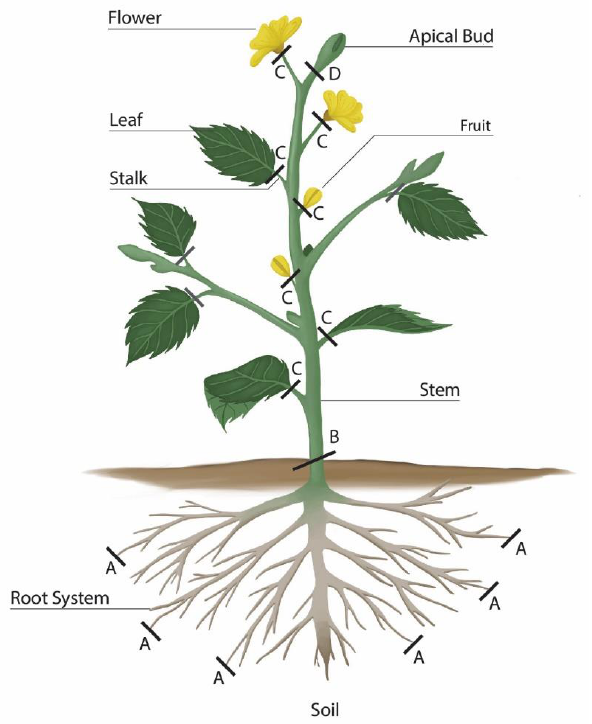
Figure 1. Barriers at different locations of plant organs and tissues as an exclusion mechanism of ions: (A) at the surface of the roots, (B) between shoot system and root system, (C) between leaves and petioles or sheaths, and (D) between apical meristems and the remaining parts of the plant.